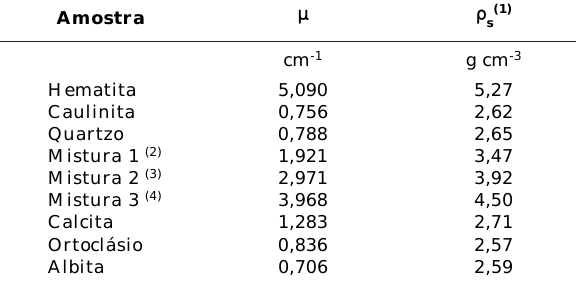
Quadro 1. Densidade dos sólidos ( rrrrr de atenuação linear ( mmmmm ) de amostras